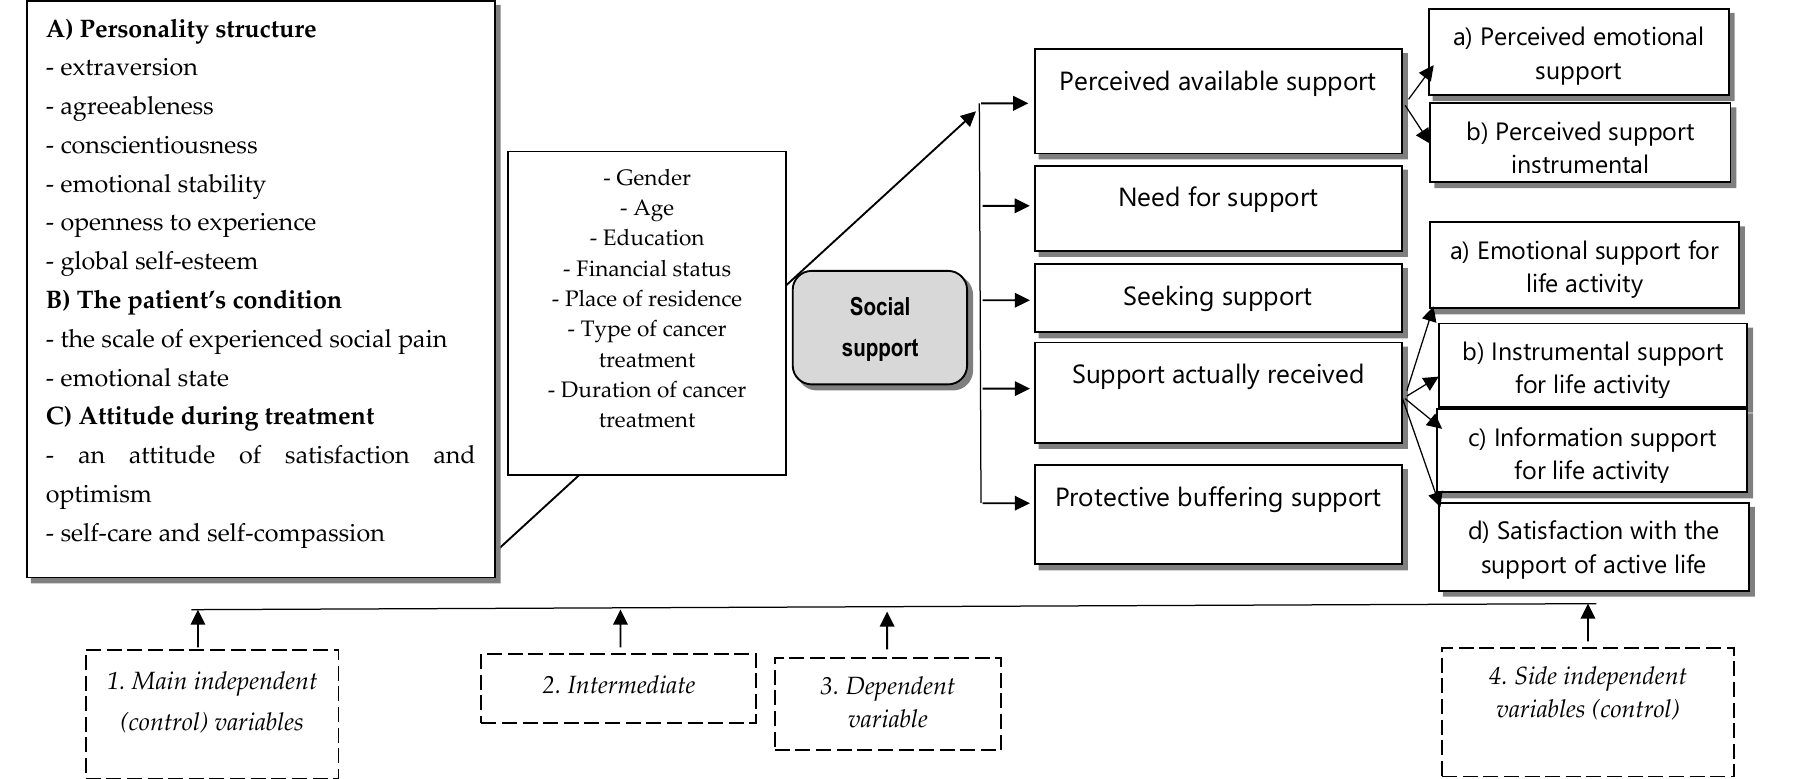
Figure 1. Theoretical model of social support for the studied patients during cancer treatment.